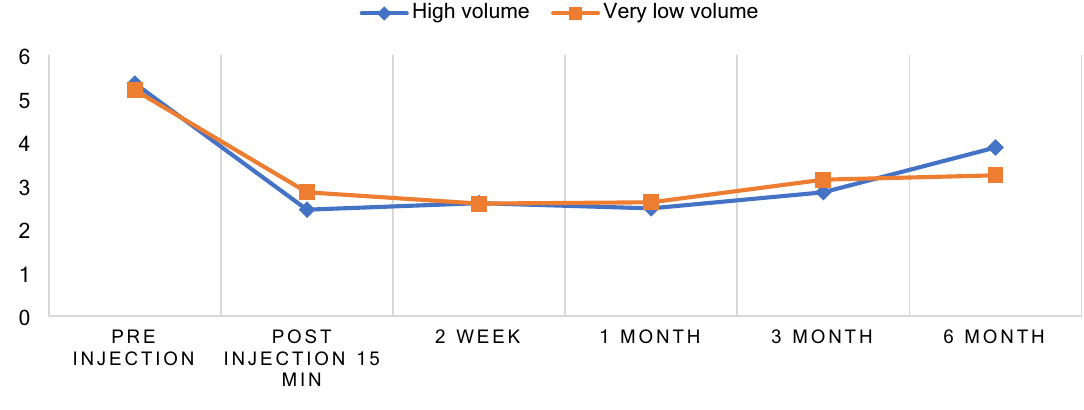
Figure 4. Change of the VAS referred by patient before and after the SCI.